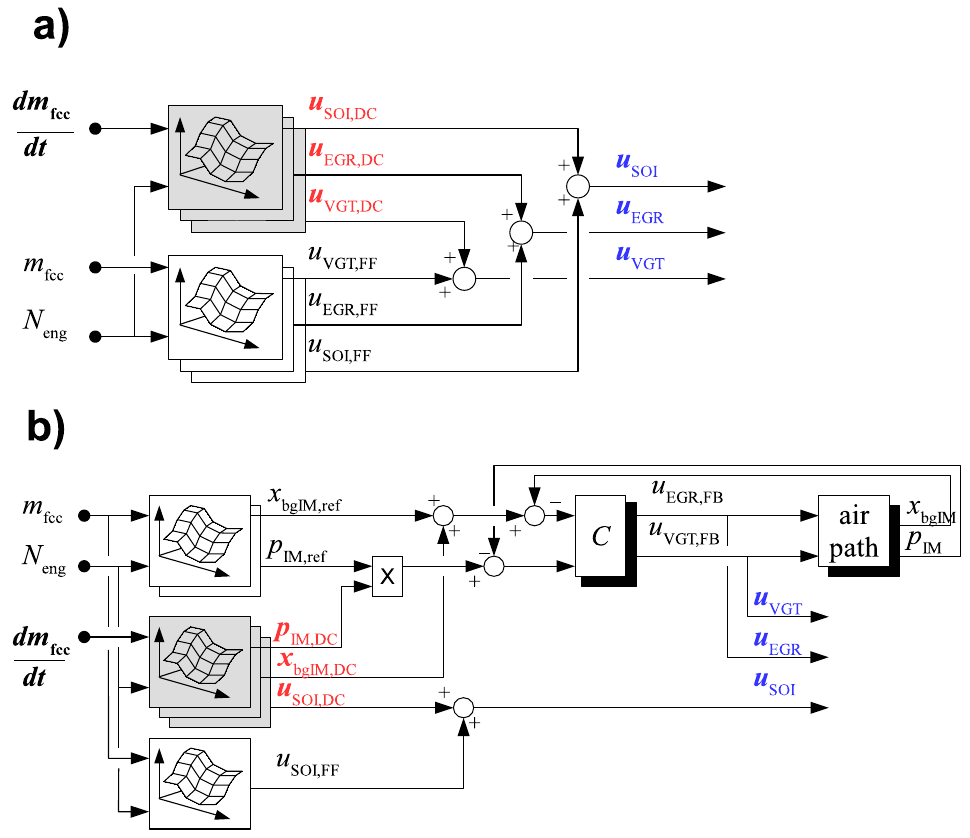
Figure 8. ( a ) FF control based on the steady-state actuator set-point maps: compensation of actuator set-point values; and ( b ) feedback (FB) control of the state variable set-point maps: compensation of state variable set-point